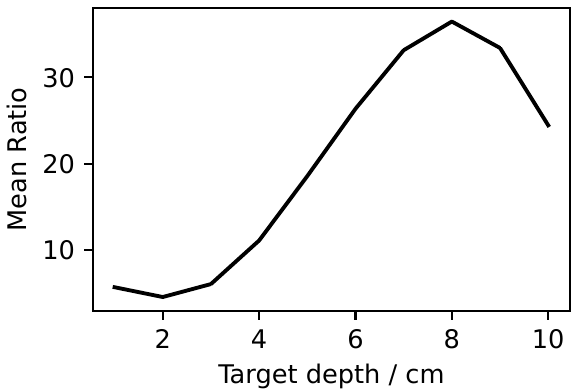
Figure 9. Ratio R at 0.6 GHz for 5 × 5 antenna distribution at different target